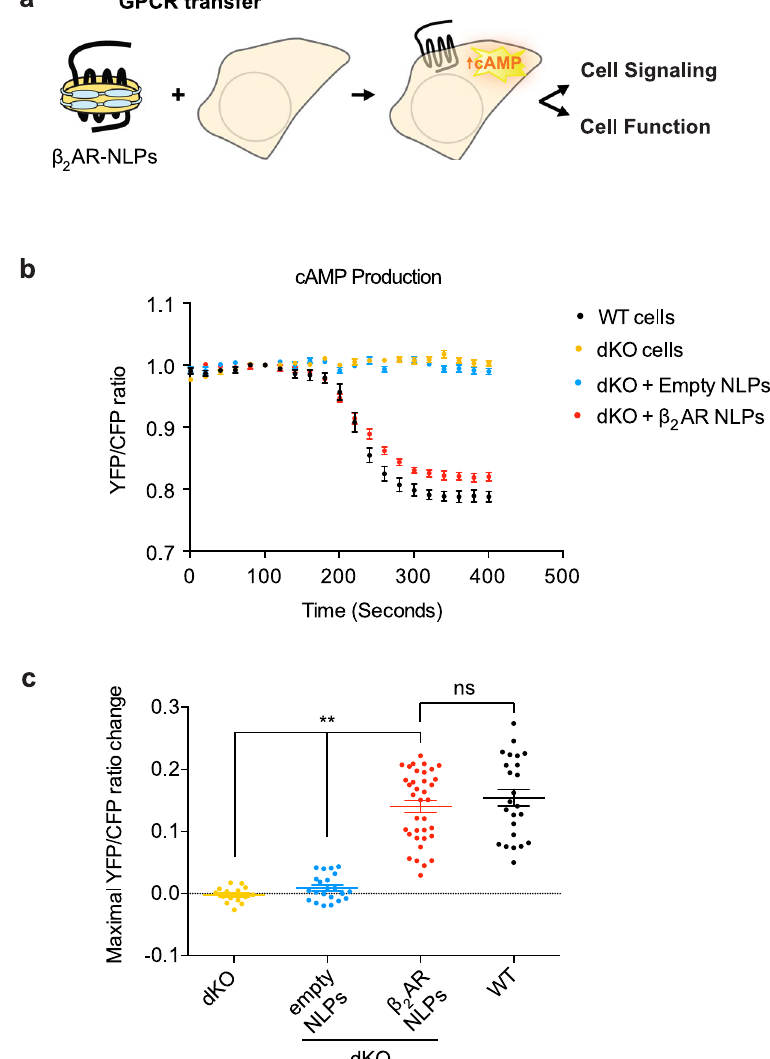
Figure 5. Nanodelivered β 2 AR can drive cellular signaling. ( a ) Schematic of GPCR nanodelivery to cellular membranes to alter cellular properties. ( b , c ) ICUE measurement of cAMP production in primary β 1 / β 2 AR double-knockout neonatal cardiac myocytes (dKO myocytes) shows that nanodisc-delivered β 2 AR is capable to elicit cellular signaling in response to the agonist isoproterenol at a level comparable to endogenous β 2 AR ( ** p < 0.01, unpaired t test). Results are shown as mean ±